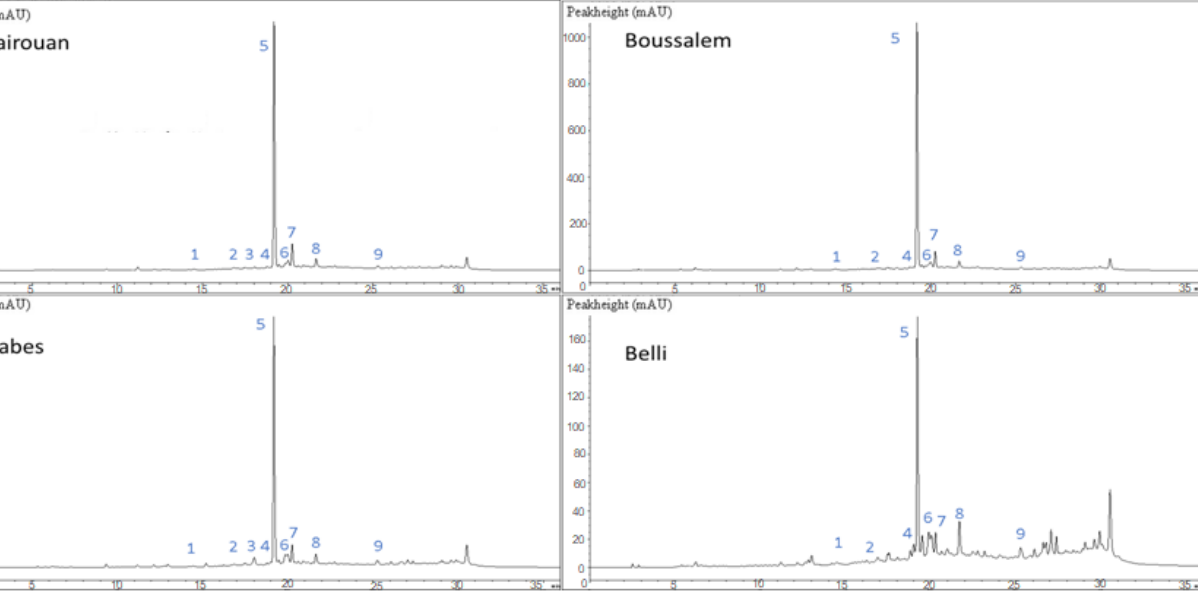
Figure 1. Chemical composition chromatographic profile of methanolic lemon verbena extracts depending on the location of collection by LC-DAD. The affiliation of the numbered peaks is reported in Table 3.